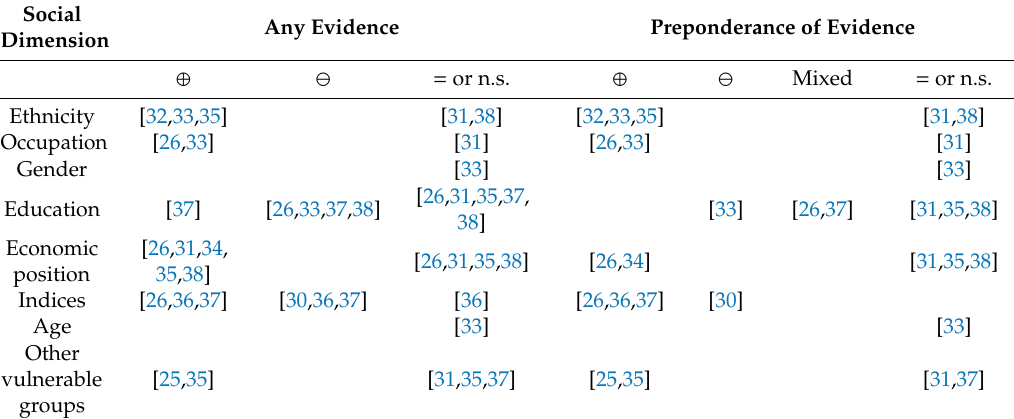
Table 5. Studies using individual level